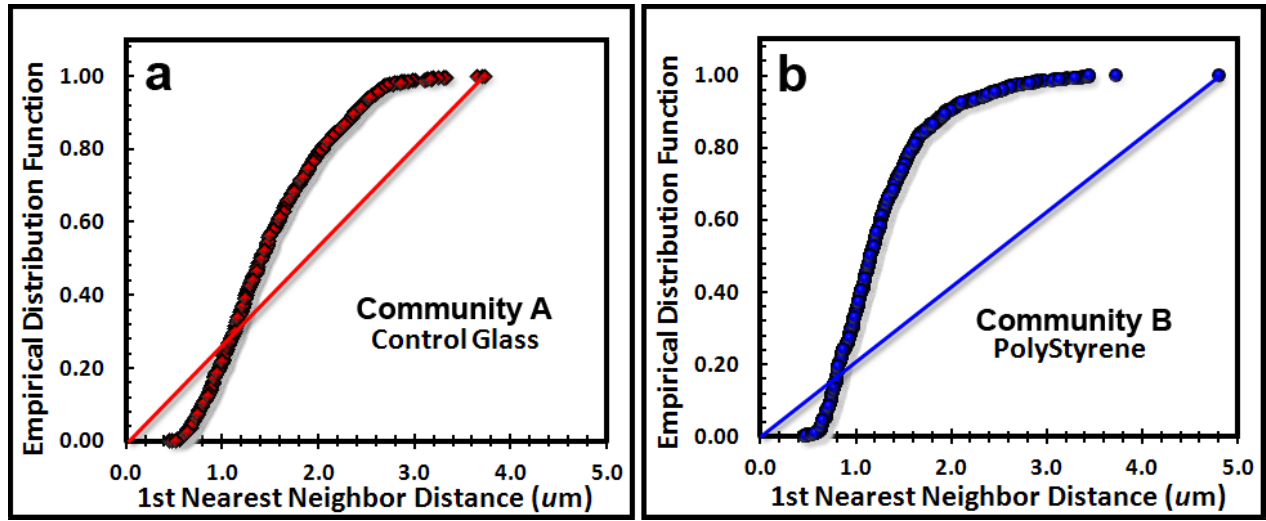
Figure 6. Cumulative empirical distribution function of the first nearest neighbor distances between individual bacteria within biofilm assemblages of community A ( a ) and community B ( b ). The diagonal trendline of complete spatial randomness is indicated in both plots for